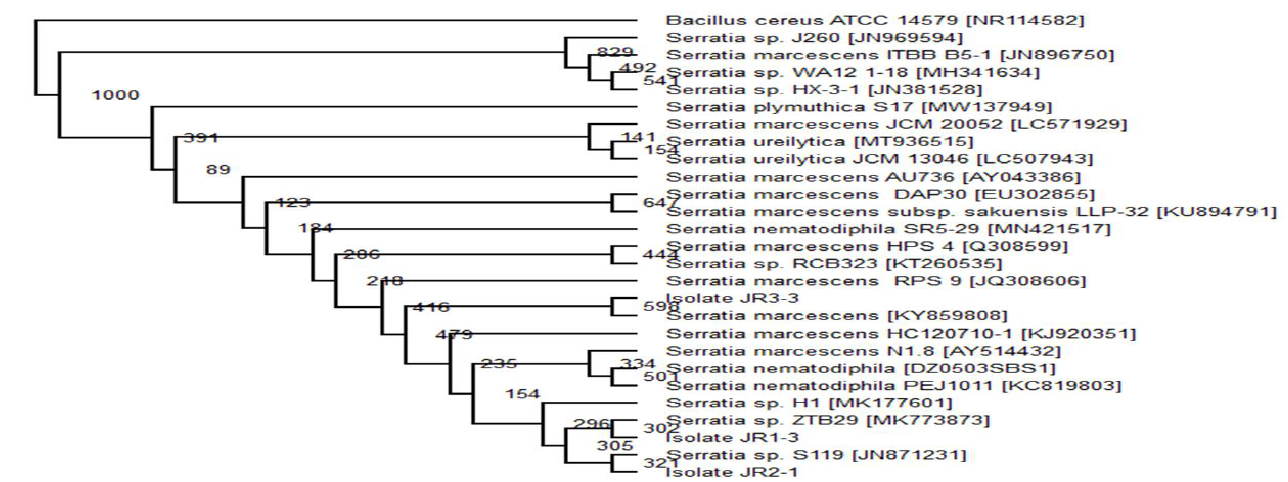
Figure 3. The cladogram was carried out based-on neighbour-joining technique illustrating the phylogenetic relationship among isolate JR1-1, JR1-2 and JR3-2 with other interconnected analogous bacterium based on 16S rRNA gene sequence examination. Bacillus cereus was the outgroup.